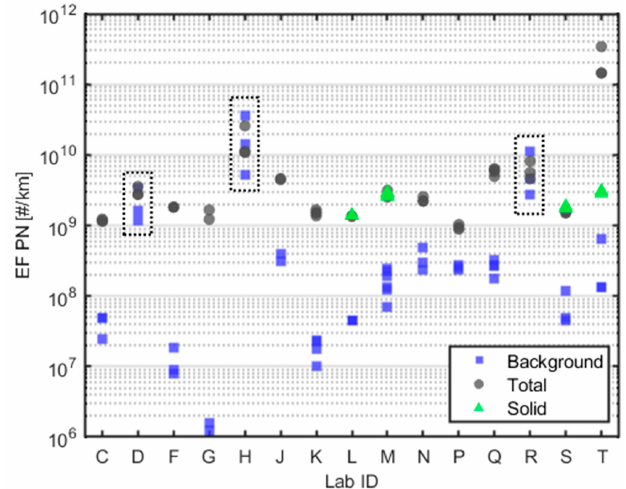
Figure 1. Overview of PN emission data for Br1Fa. Test level background concentrations of labs D, H, and R are in the same order as emission levels and are excluded from further analysis. To estimate the number of particles generated by the sliding friction between the brake assembly counterparts, the signal-to-noise ratio (SNR) needs to be sufficiently high. The emissions are not detected if the signal is smaller than or equal to the background concentration (“noise”) in the constant volume sampling (CVS) tunnel. On average, the background concentrations in the CVS tunnel were at least one order of magnitude below the measured emission level. However, as shown in Figure 1, 3 out of 16 labs reported PN background concentrations in the same order of magnitude as the actual emission levels. The PNC signal from these three labs overlay with random noise, e.g., sharp and unexpected spikes (ca. 4 × 10 4 #/cm³), which may indicate contamination or a faulty meas- urement system. Additionally, there were sudden changes in background levels as shown in Figure 2. In the case of the three labs, the background levels were similar to actual emis- sion levels recorded during braking events (1 × 10 3 − 2 × 10 3 #/cm 3 ). To avoid biasing the overall assessments, the results from these labs were excluded from any further data anal- ysis.